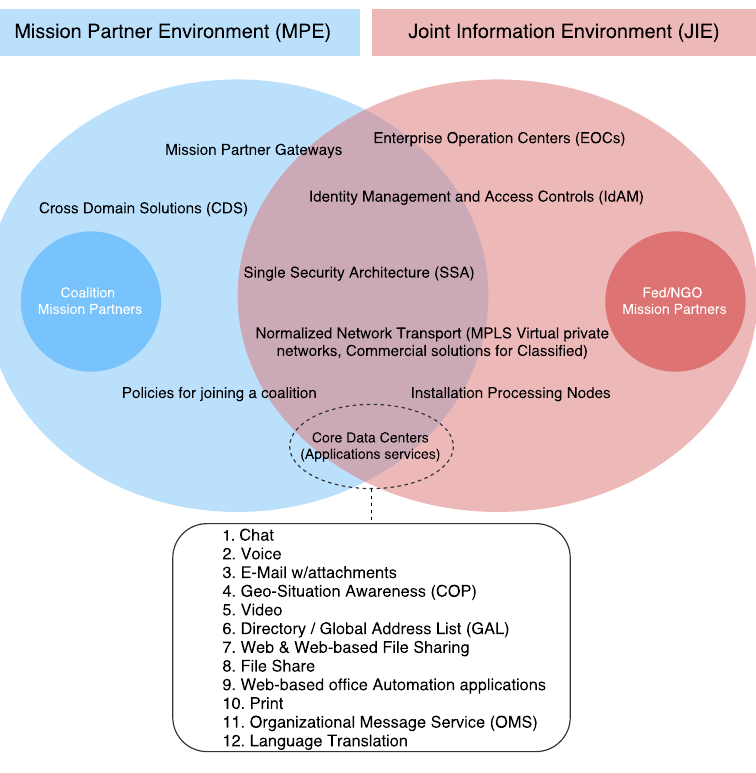
Figure 6. Requirements and application services for commanders.